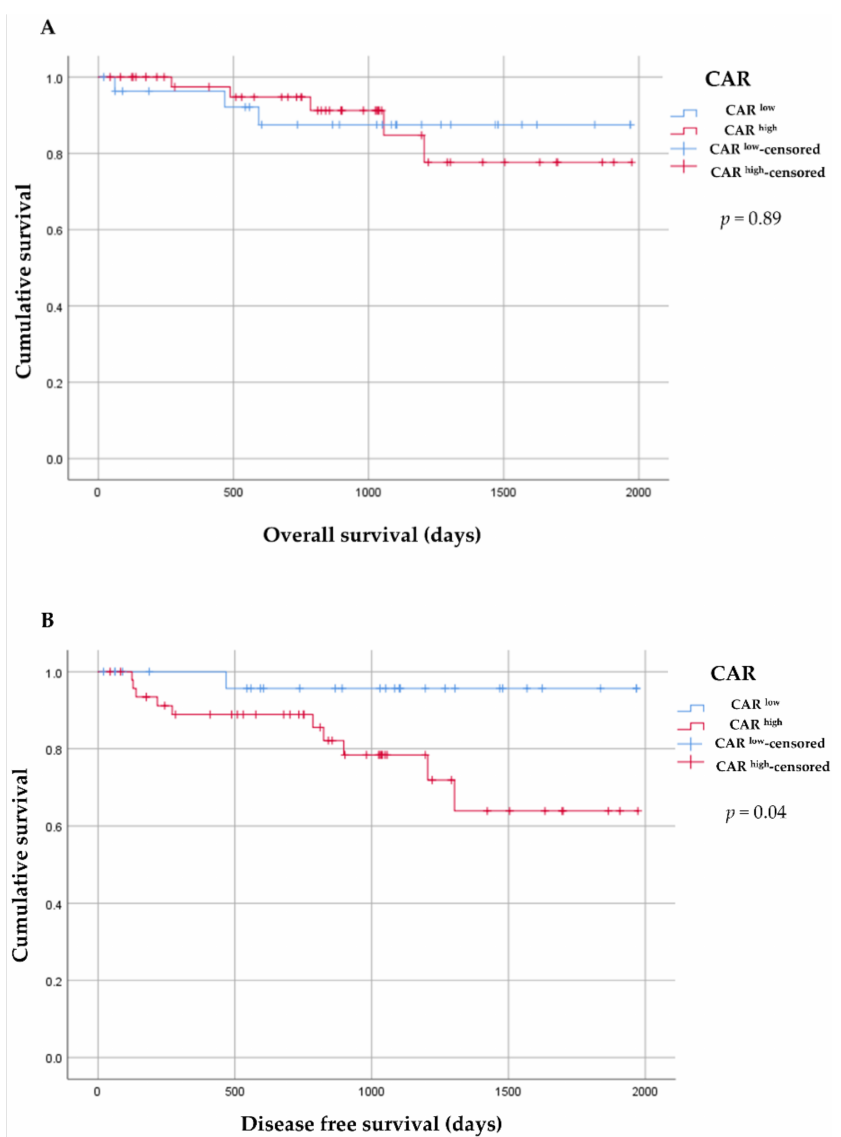
Figure 4. Kaplan–Meier survival curves. ( A ) Overall survival (OS). ( B ) Disease free survival (DFS). Kaplan–Meier survival curves showing the difference between the CAR high and CAR low groups in DFS. OS showed no significant difference; however, CAR high group was significantly shorter in